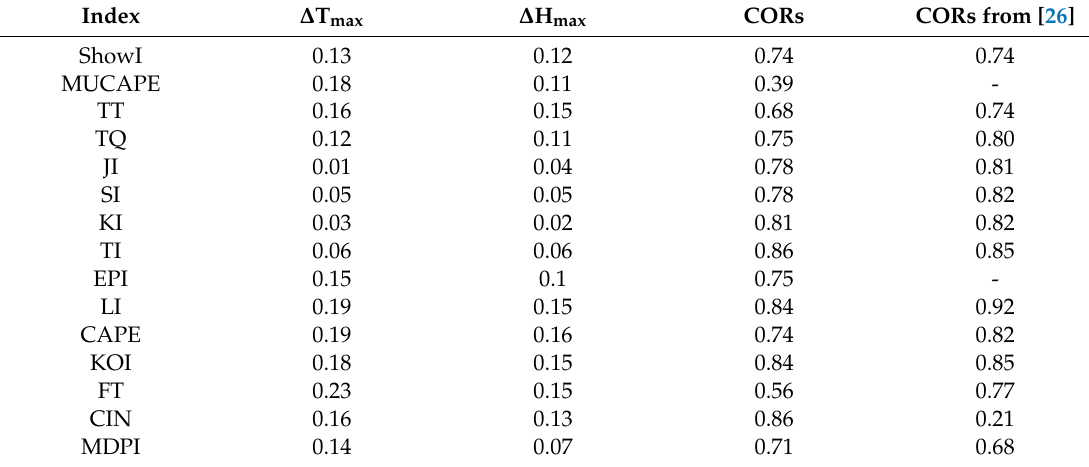
Table 3. TSS maximum di ff erence ( ∆ T max ) and HSS maximum di ff erence ( ∆ H max ) between microwave and radiosonde values of each index (second and third columns). The correlation coe ffi cients (CORs) between microwave and radiosonde values of the indices obtained in this work (fourth column) and in [26] (fifth